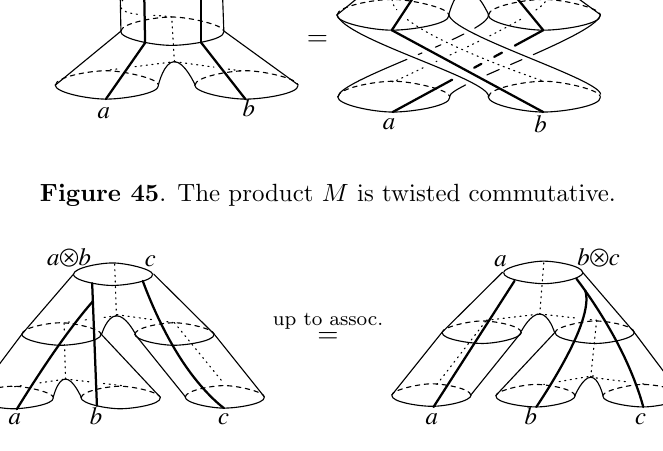
Figure 46 . The product M is associative up to the